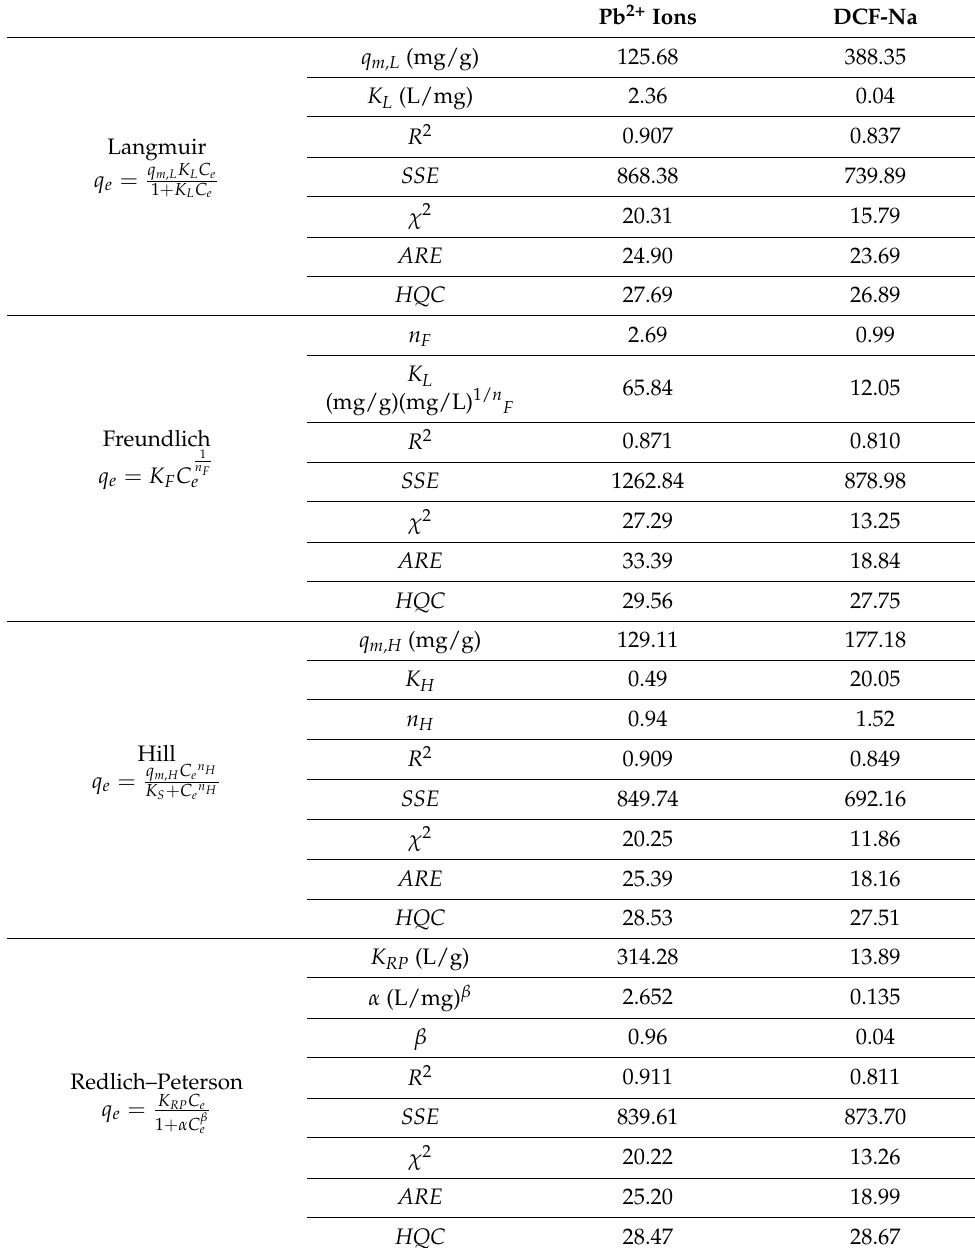
Table 4. Isotherm parameters for the adsorption of DCF-Na and Pb 2+ ions.